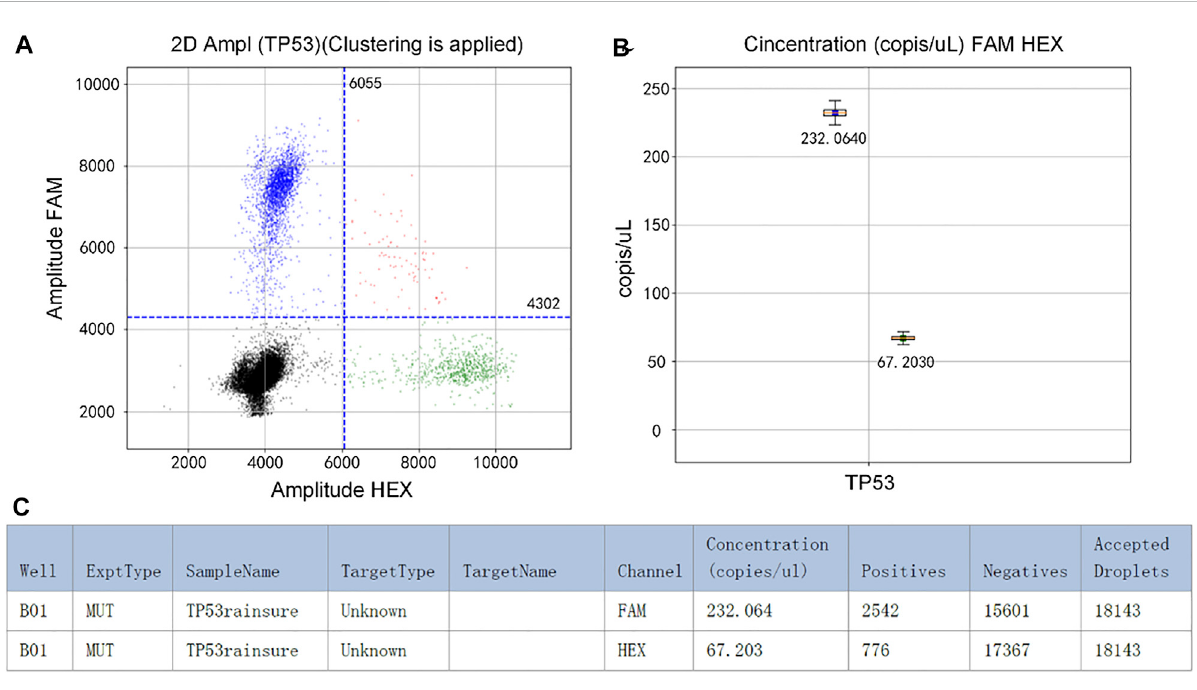
FIGURE 2 (A) Scatter plot by RainSure dPCR; (B) Initial DNA concentration calculated by RainSure dPCR; (C) Microdroplet data derived by RainSure